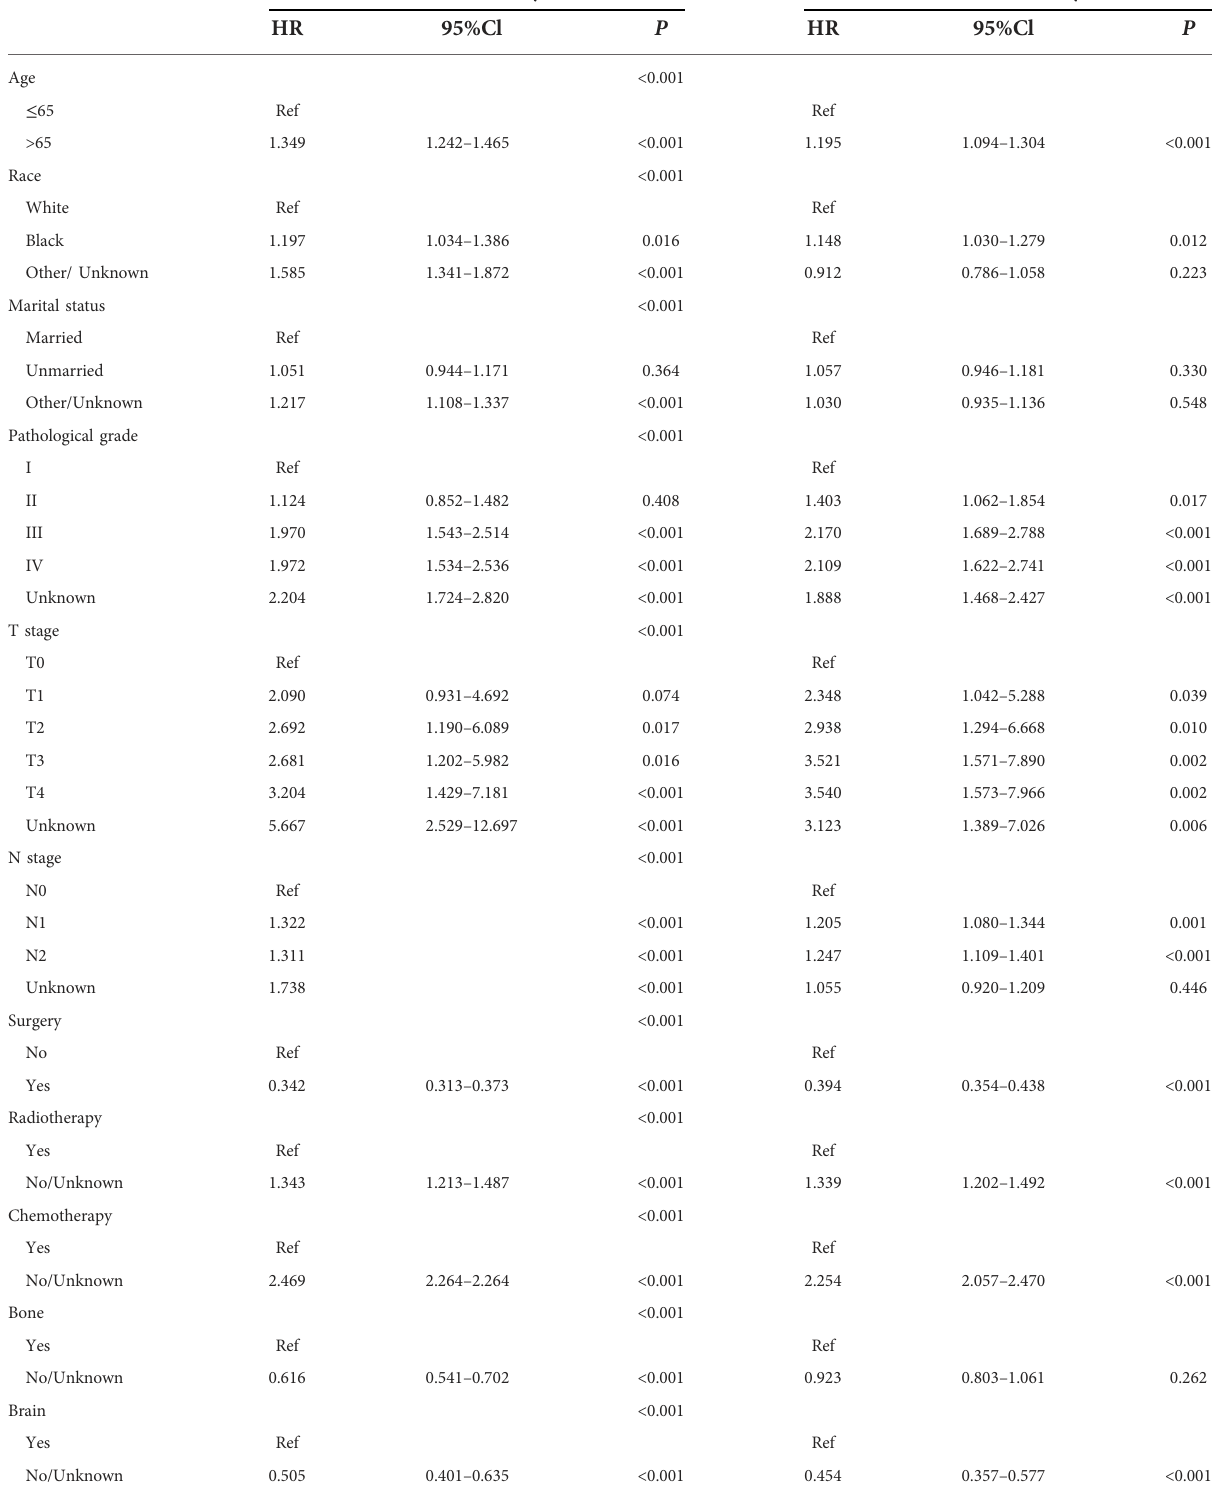
TABLE 2 Univariate and multivariate analyses of variables associated with OS in the training cohort ( n